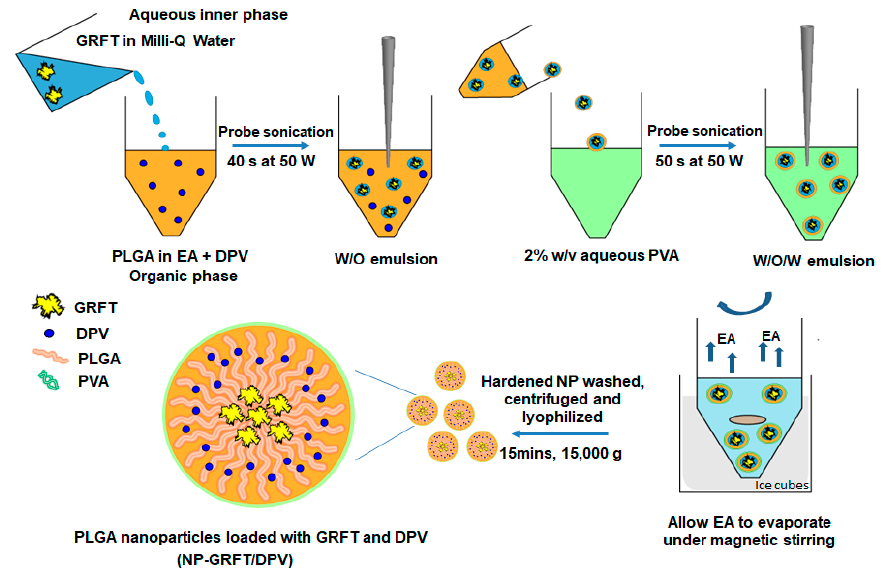
Figure 1. Schematic representation of DPV and GRFT-loaded PLGA nanoparticle preparation by double emulsion-solvent evaporation method.